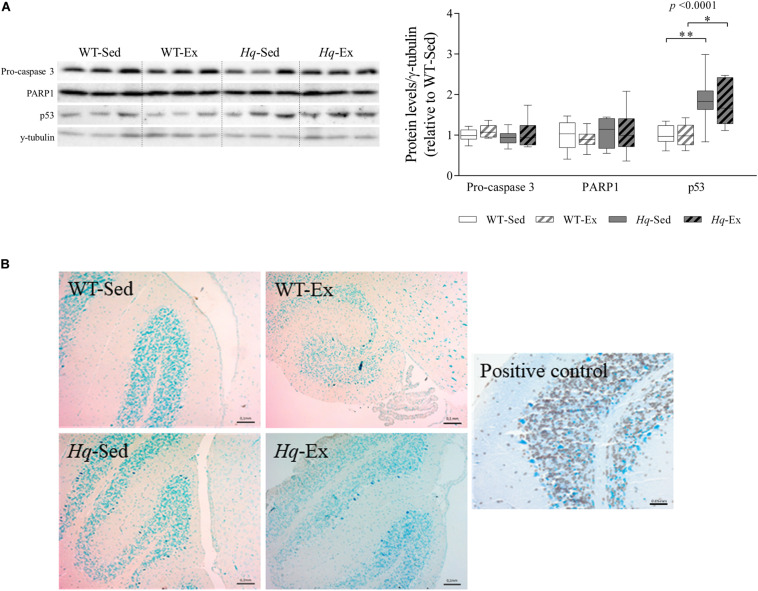
Apoptosis markers. (A) Western blot analysis of pro-caspase 3, poly [ADP-ribose] polymerase 1 (PARP1) and p53 in cerebellum homogenates of wild-type sedentary (WT-Sed, n = 12) and exercise-trained (WT-Ex, n = 11) mice, and of Hq sedentary (Hq-Sed, n = 11) and exercise-trained (Hq-Ex, n = 10) mice. Densitometry analysis: protein levels were normalized to γ-tubulin levels; data (median, interquartile range, and min and max values) are expressed relative to levels in the WT-Sed group. Significant p-values for the group effect (Kruskal-Wallis test) are shown above the corresponding boxes. Symbols for significant differences in post hoc pairwise comparisons: ∗p < 0.05; ∗∗p < 0.01 for Hq-Sed vs. WT-Sed, and Hq-Ex vs. WT-Ex. (B) Detection of apoptotic nuclei in cerebellar cortex by TUNEL assay, counterstained with hematoxylin (10×). DNase-treated samples were used as a positive control. Analyses were performed in 12 WT-Sed, 11 WT-Ex, 11 Hq-Sed and 9 Hq-Ex mice (1 section per mouse).